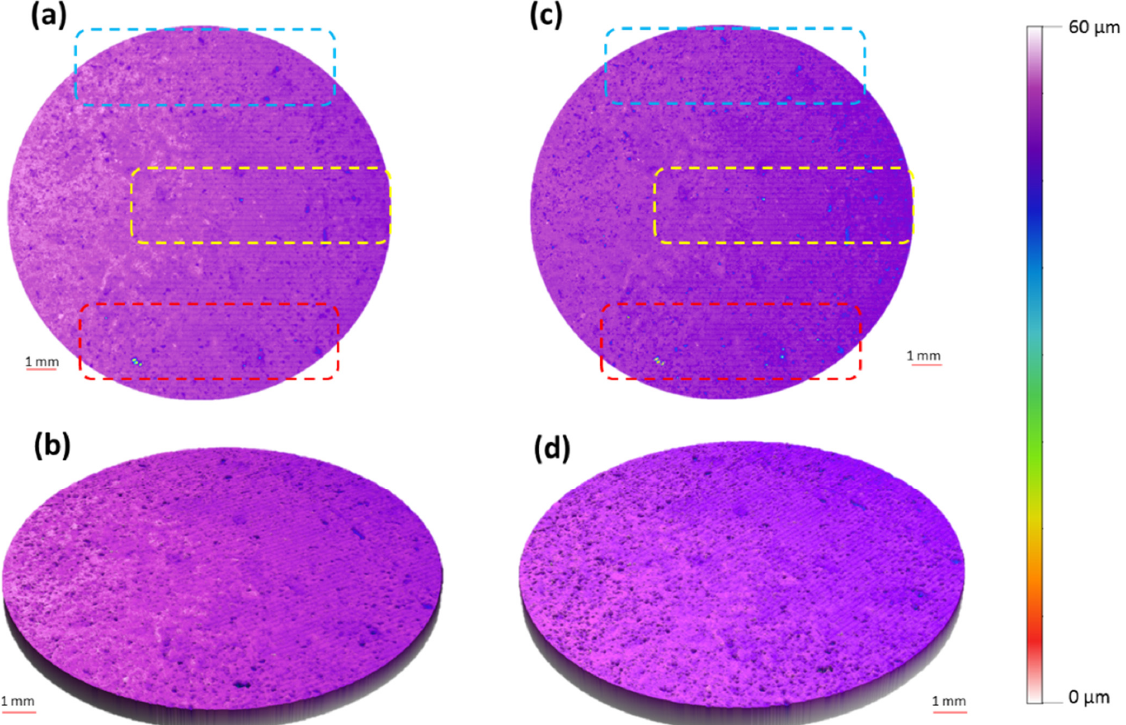
Figure 5. ( a ) 2D and ( b ) 3D surface texture images produced using optical profilometry. These images are adapted from [3] with permission from the publisher, Royal Society Chemistry. ( c ) 2D and ( d ) 3D surface texture images produced using the new developed ETL-based variable focus imaging